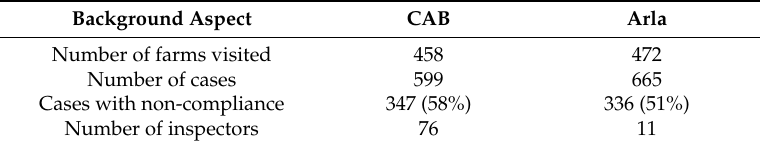
Table 1. Information about the number of farms, cases and inspectors, and prevalence of non-